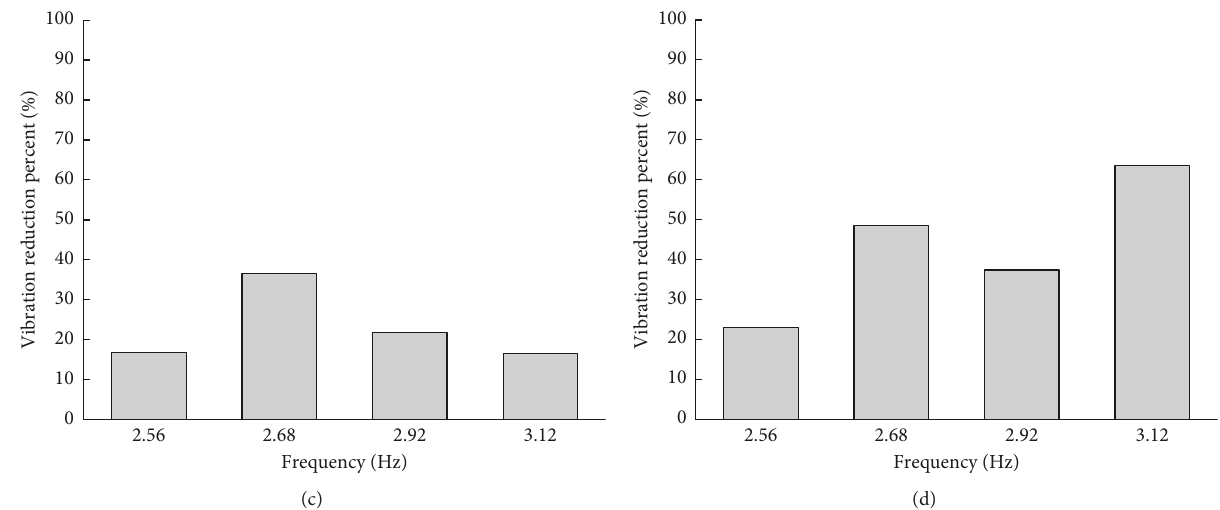
Figure 19: Experimental results for the evaluation parameters under two earthquake conditions. Evaluation indices of acceleration results under the (a) El-Centro NS seismic wave with various frequencies, (b) Taft EW seismic wave with various frequencies; evaluation indices of displacement results under the (c) El-Centro NS seismic wave with various frequencies. (d) Taft EW seismic wave with various